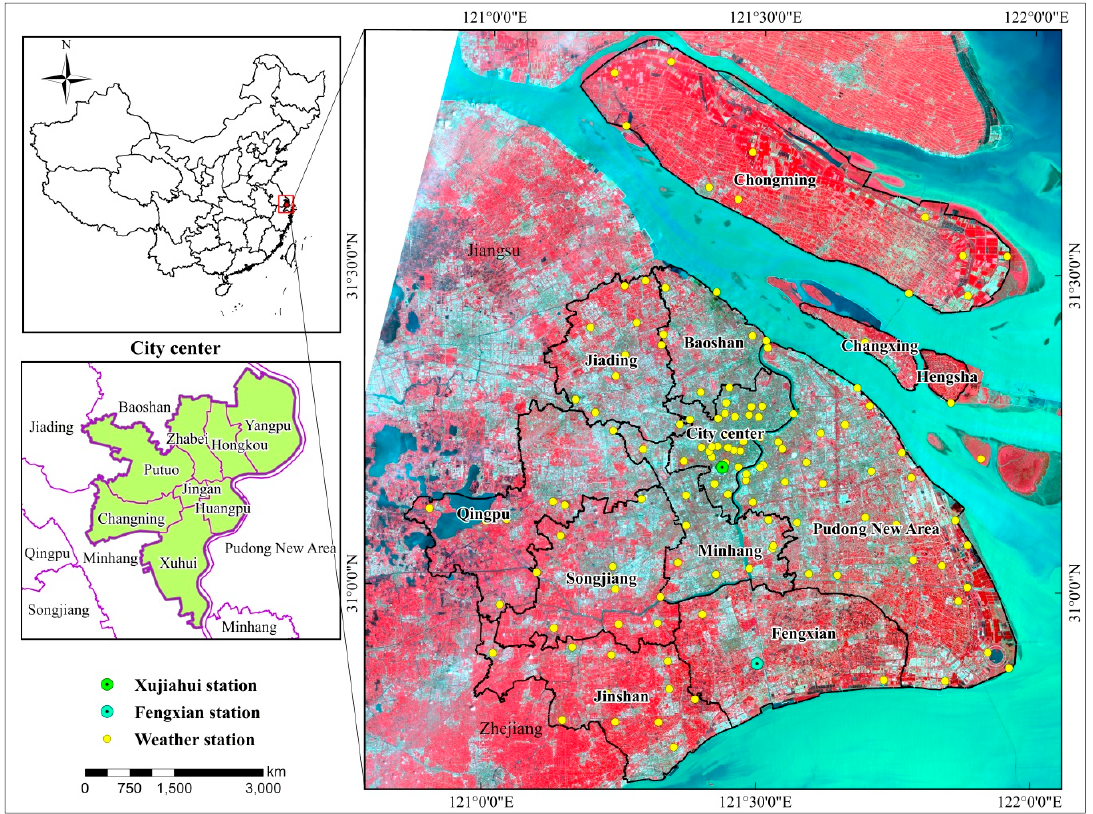
Figure 1. Location of study area and distribution of weather stations.